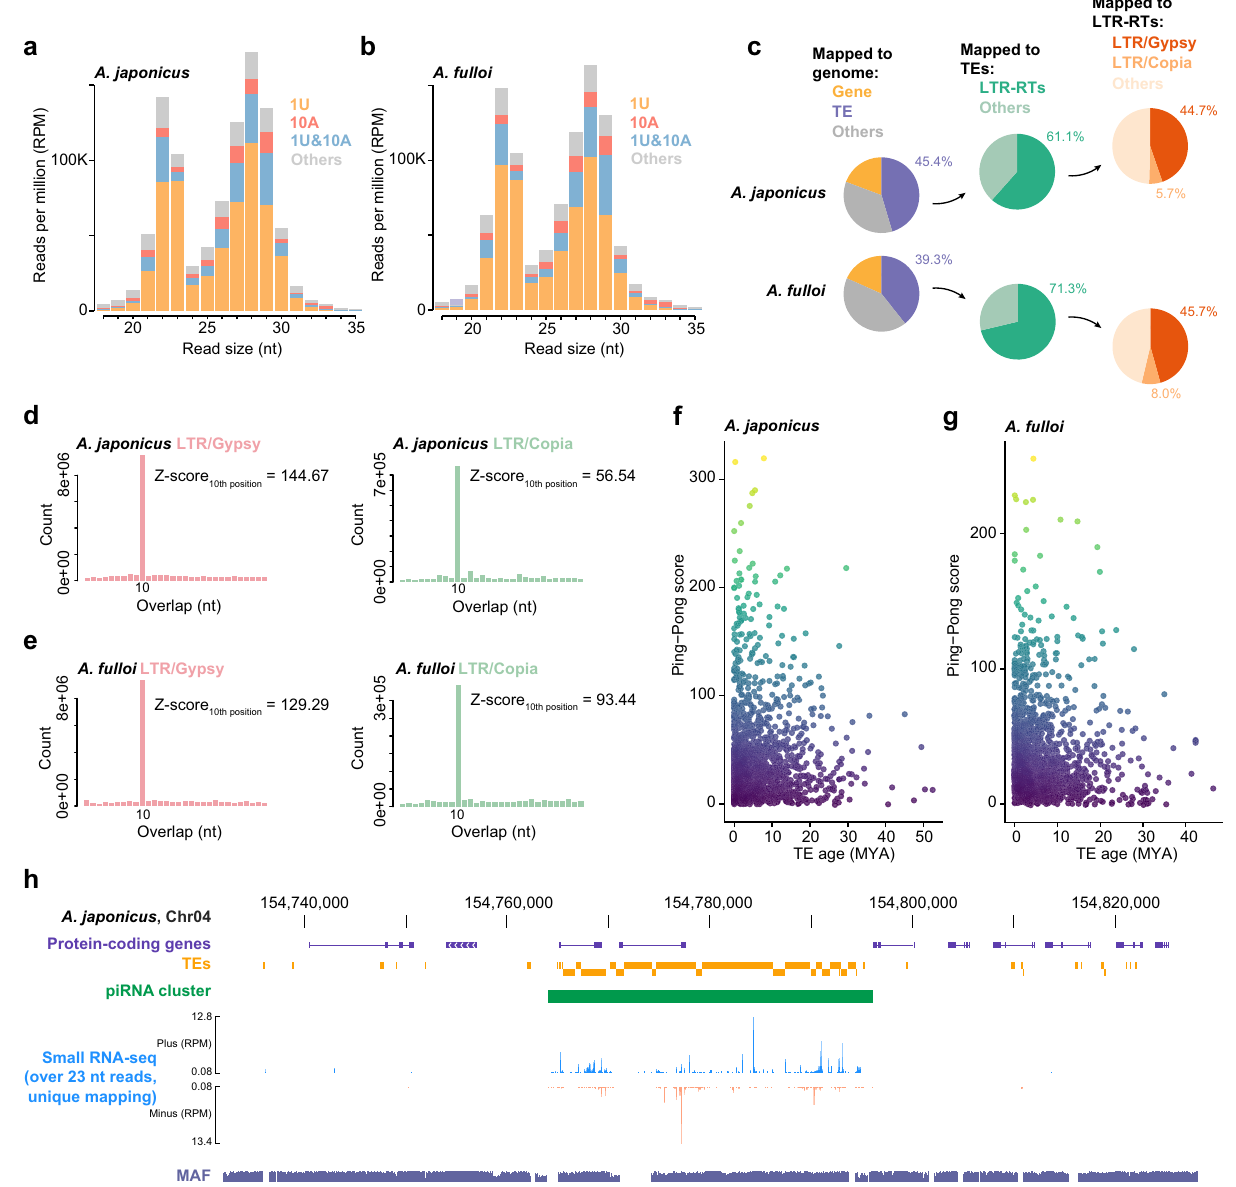
Fig. 4 | piRNAs in the Anastatus genomes. Distribution of small RNA read sizes mapping to the A. japonicus genome ( a ) and the A.fulloi genome ( b ).Fourkindsof reads are shown in different colors in each bar in the size distribution. c Mapping statistics of piRNA reads to the two Anastatus genomes. d Analysis of the 5´-to-5´ distance between piRNAs mapped to opposite strands of two types of LTR retro- transposons ( Gypsy and Copia ) in A.japonicus . The same analysis of A. fulloi is also